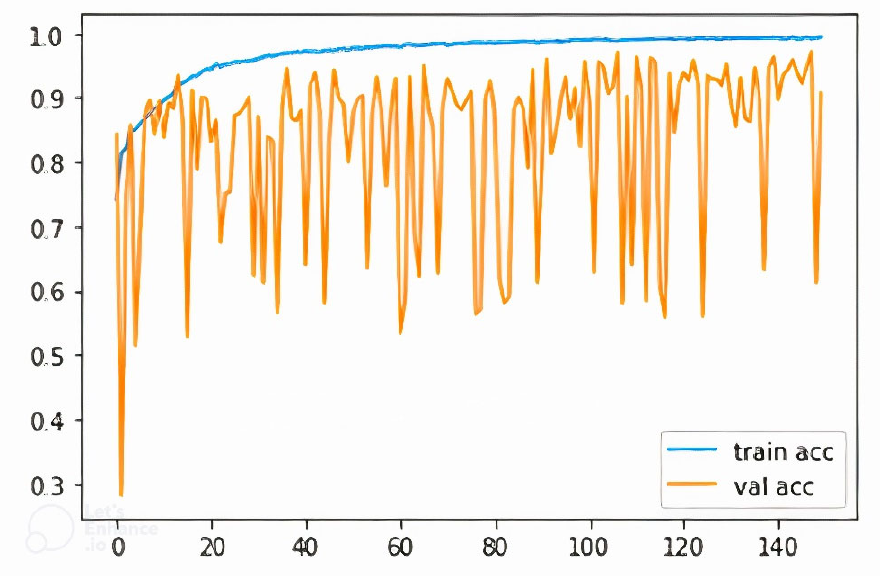
Figure 20. Training and validation accuracy for the best performing Xception model. (train acc: training accuracy, val acc: validation accuracy).